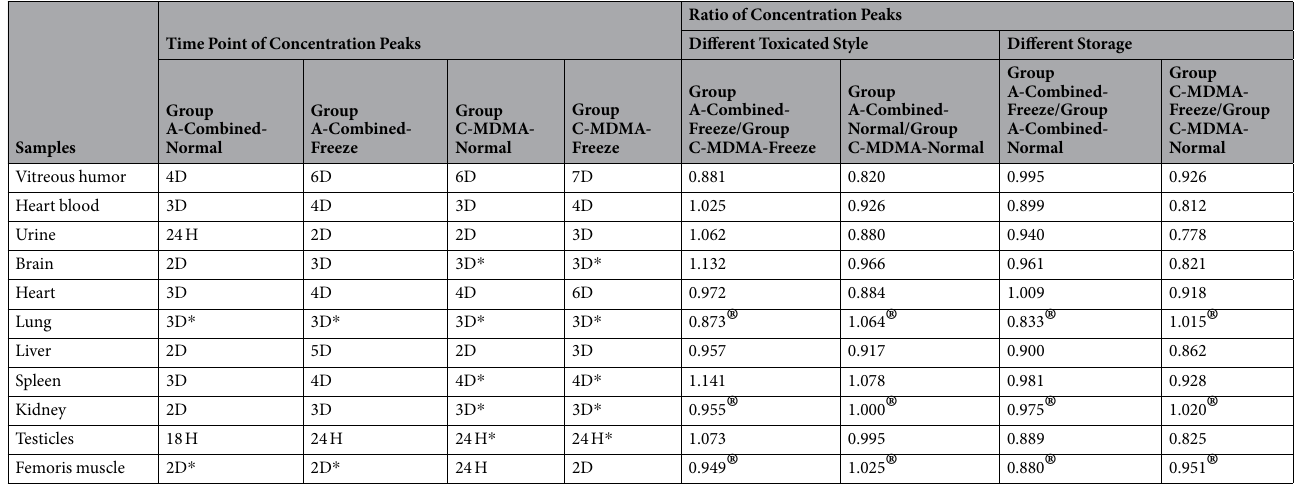
Table 5. Comparison of Concentration Peaks between Groups during